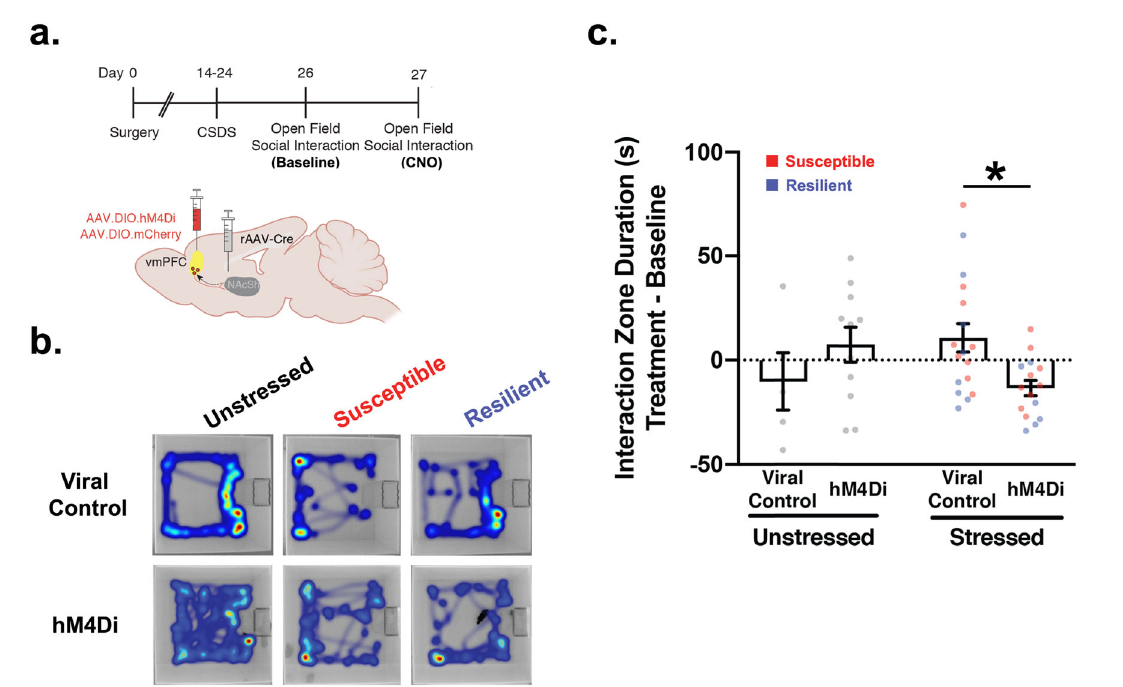
Fig. 4 | vmPFC-NAcSh activity supports social approach behavior following social defeat. a Experimental timeline and schematic of surgical strategy for viral injections for driving selective expression of hM4Di-mCherry inhibitory DREADDs or viral control in vmPFC-NAcSh cells. Created with BioRender.com b Heatmaps showing representative behavior of hM4Di-mCherry and viral control injected animals(unstressedcontrols,susceptibleandresilientanimals)afterCNOinjection. c Social interaction behavior (total interaction zone time) of stressed (susceptible